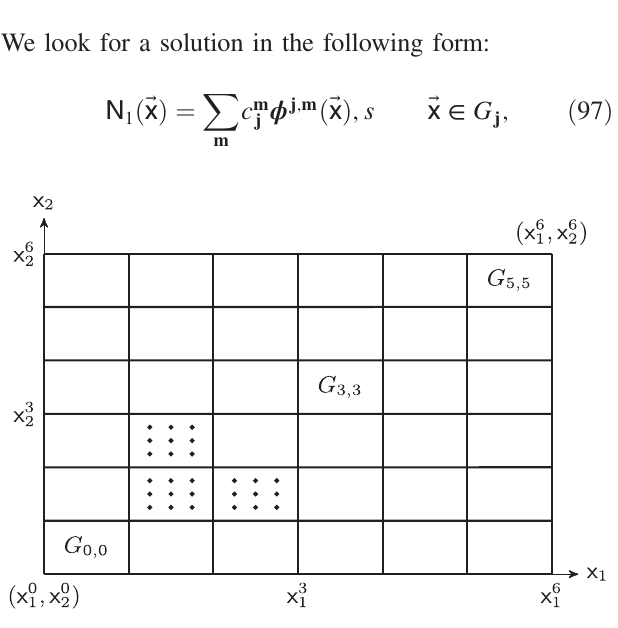
FIG. 1. Cells and collocation points for the PPCM for d ¼ 2 , N 1 ¼ N 2 ¼ 3 , m ¼ 3 , r ¼ 1 . The collocation points are shown only in three cells, while, of course, they exist in all of